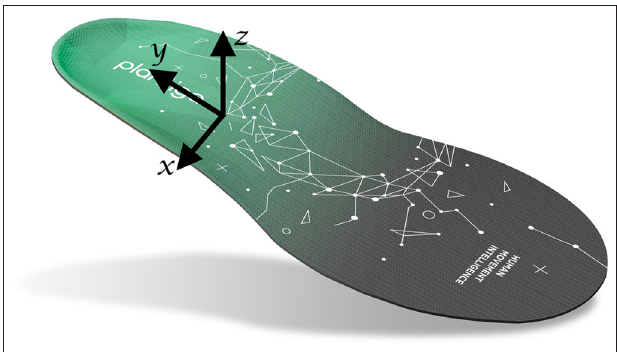
FIGURE 1 | Plantiga insole-embedded inertial measurement